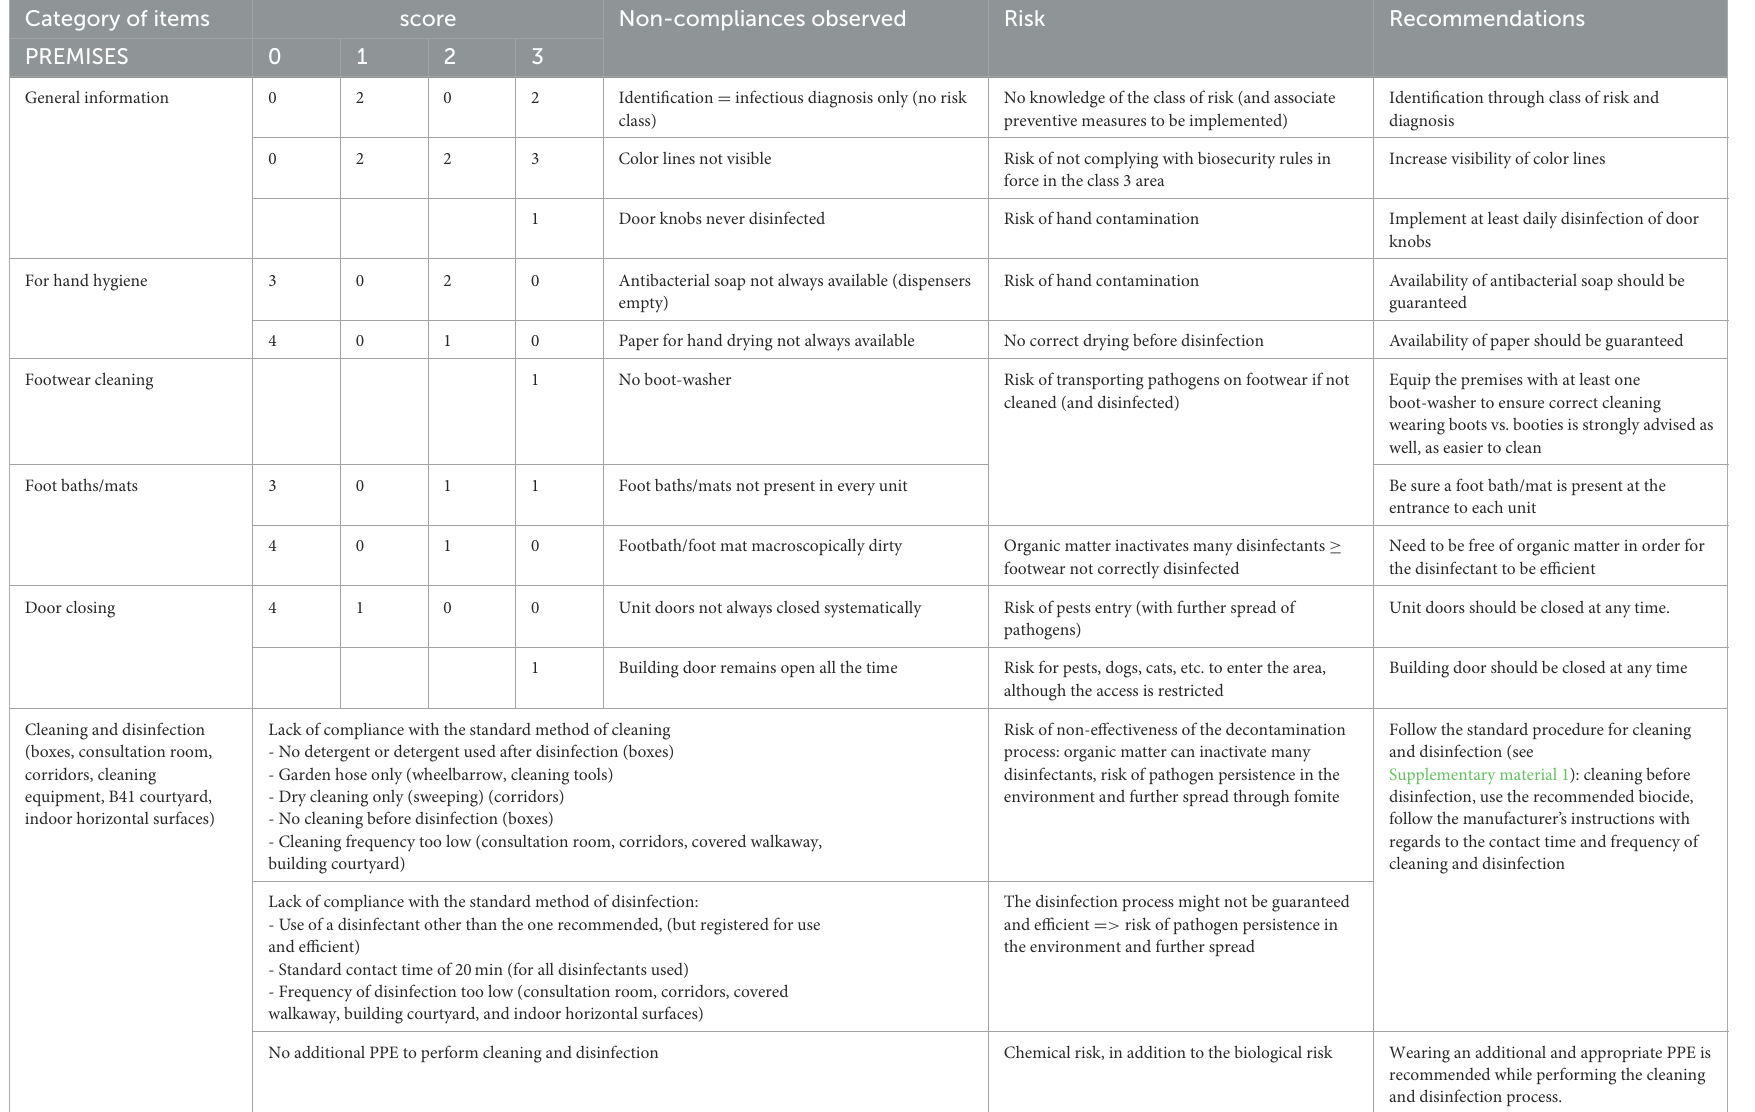
TABLE 2D Biosecurity deficiencies observed when performing the internal audit in the Equine class 3 area—category “PREMISES”. Category of